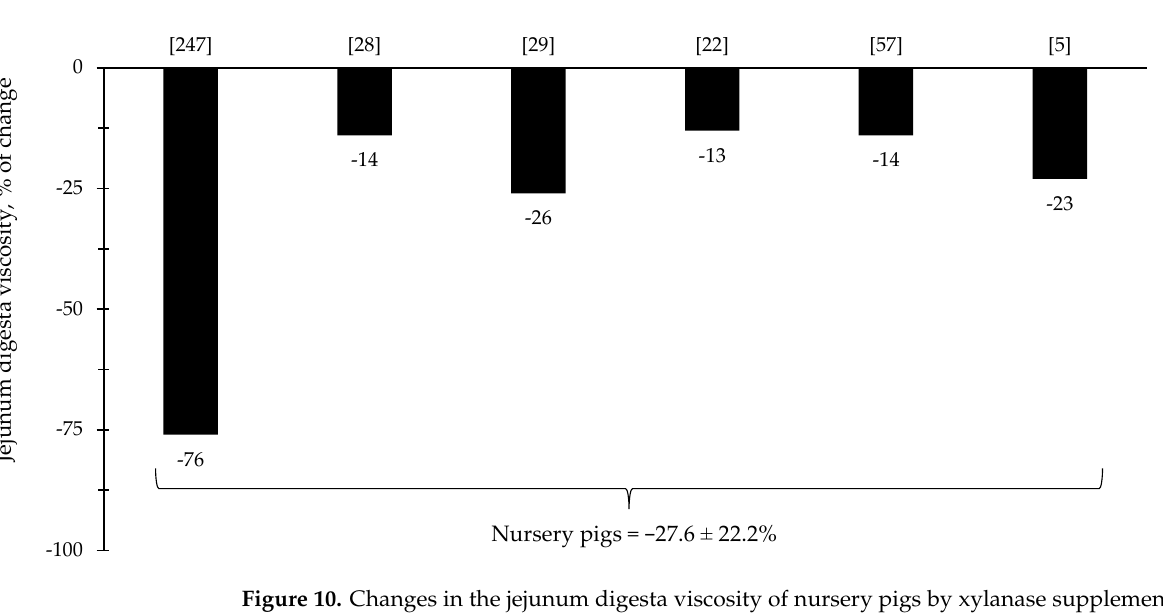
Broiler chickens = − 37 ± 22.6% Figure 9. Changes in the jejunum digesta viscosity of broiler chickens by xylanase supplementation among the studies displayed in Table 3 that showed changes in the jejunal digesta viscosity. The studies were selected from peer-reviewed literature available after 2000. The percentage of change refers to a statistically significant ( p < 0.05) and tendency (0.05 ≤ p < 0.10) effects of xylanase on the jejunal digesta viscosity reported from each respective study. The described effects were in comparison with treatments containing no xylanase. The average changes in the jejunal digesta viscosity of broiler chickens by xylanase supplementation were calculated excluding the studies that showed no effect.